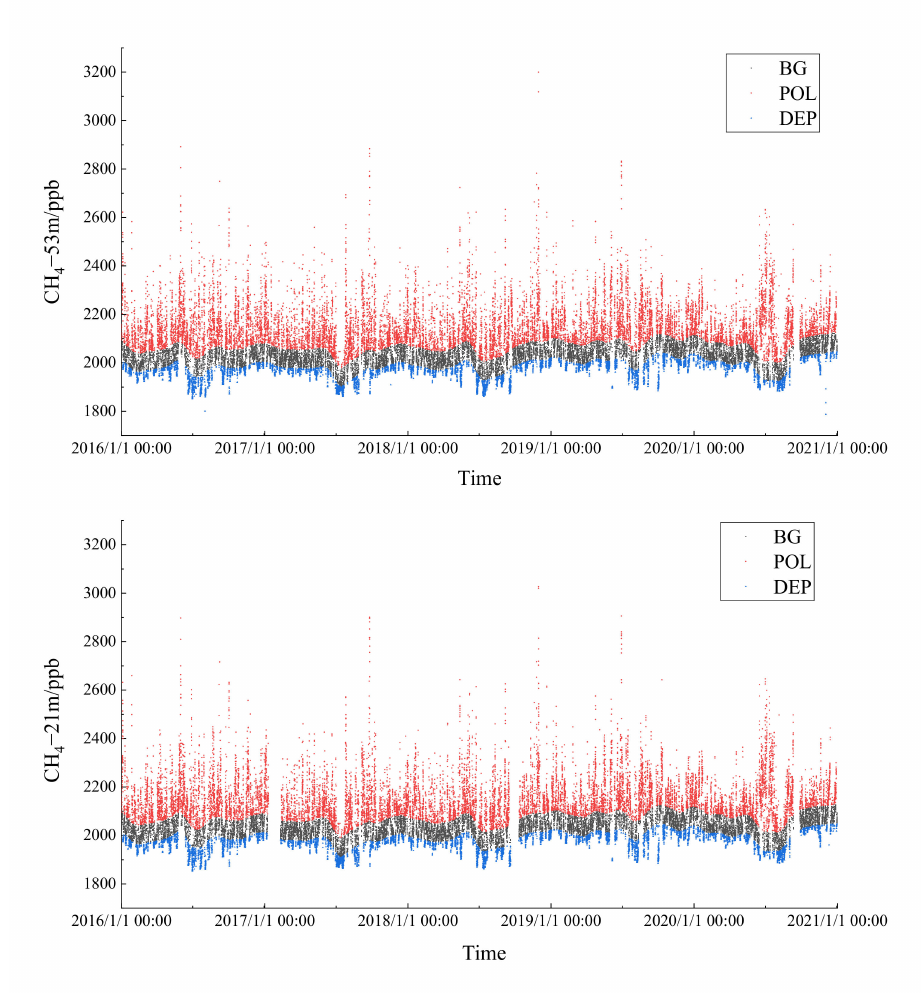
Figure 4. Hourly CH 4 concentration at Lin’an station after REBS